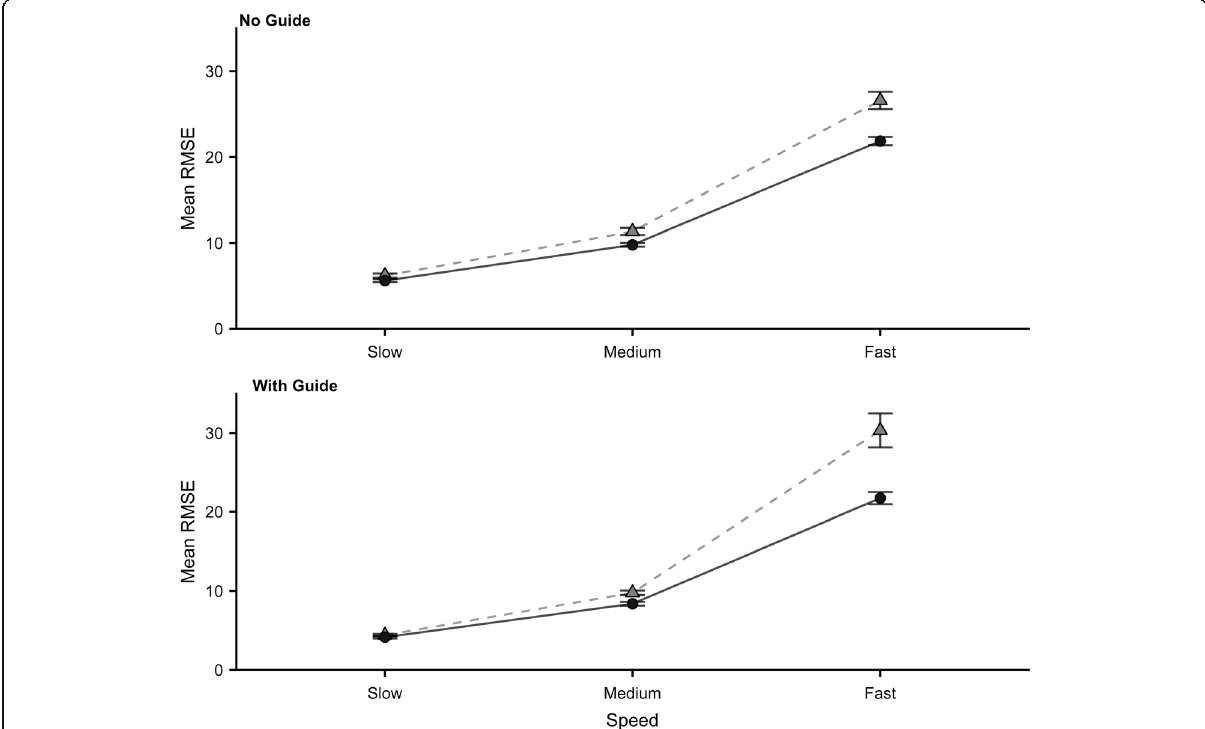
Fig. 2 Tracking . Mean root mean square error (RMSE) for both groups (Control = circles, TN = triangles) across all speeds. The top plot shows the No Guide condition and the bottom plot the With Guide